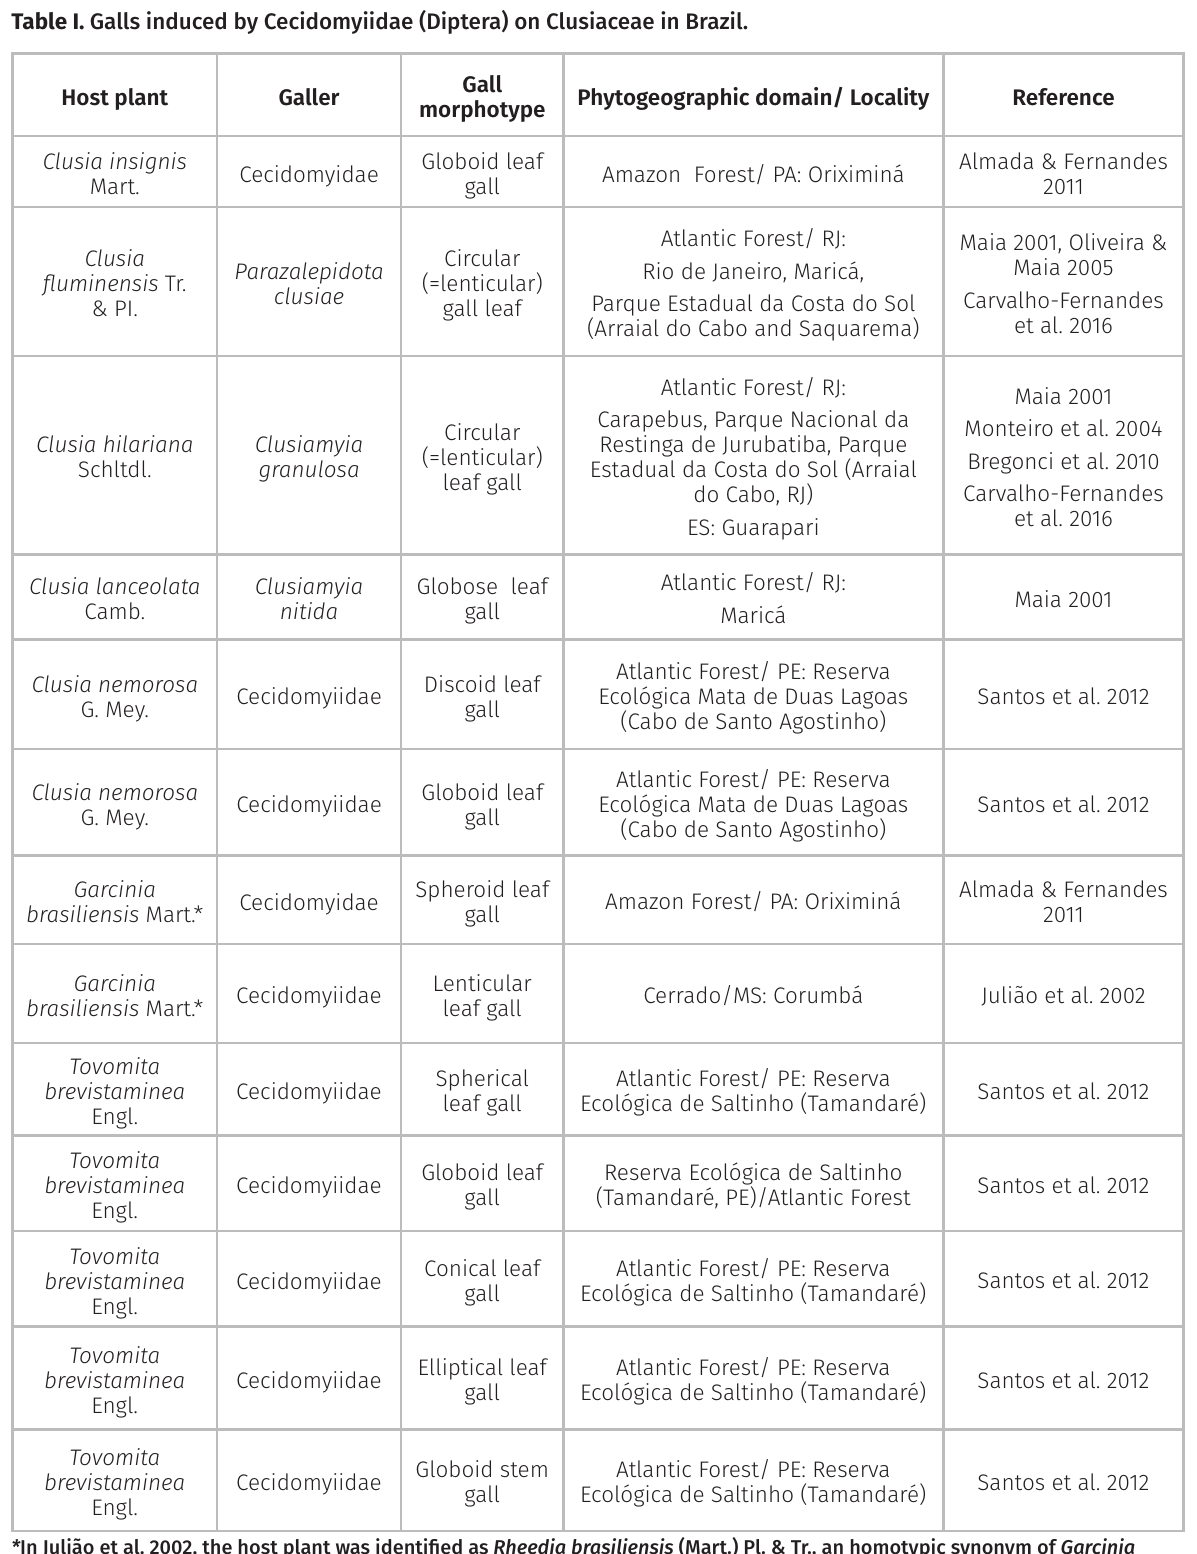
Table I. Galls induced by Cecidomyiidae (Diptera) on Clusiaceae in Brazil. Host plant